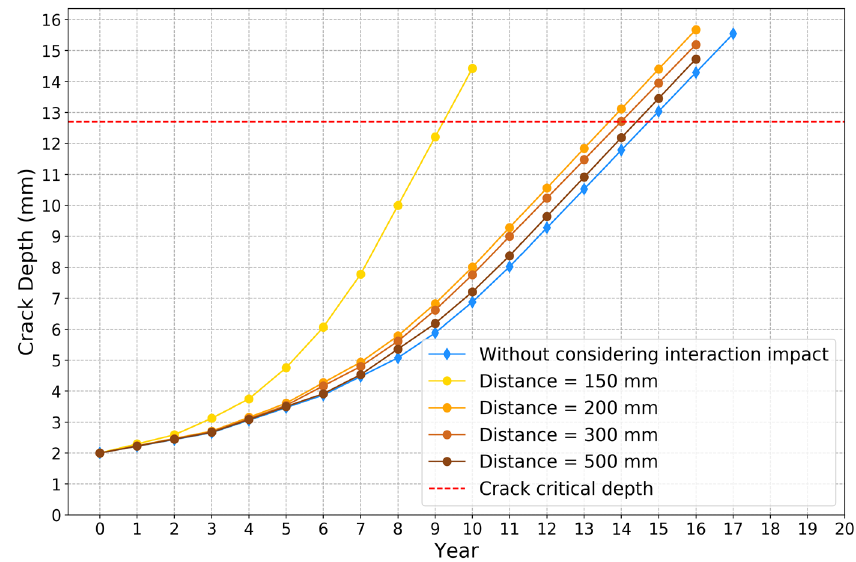
Figure 14. Crack depth growth curves for different distances based on approach 2.